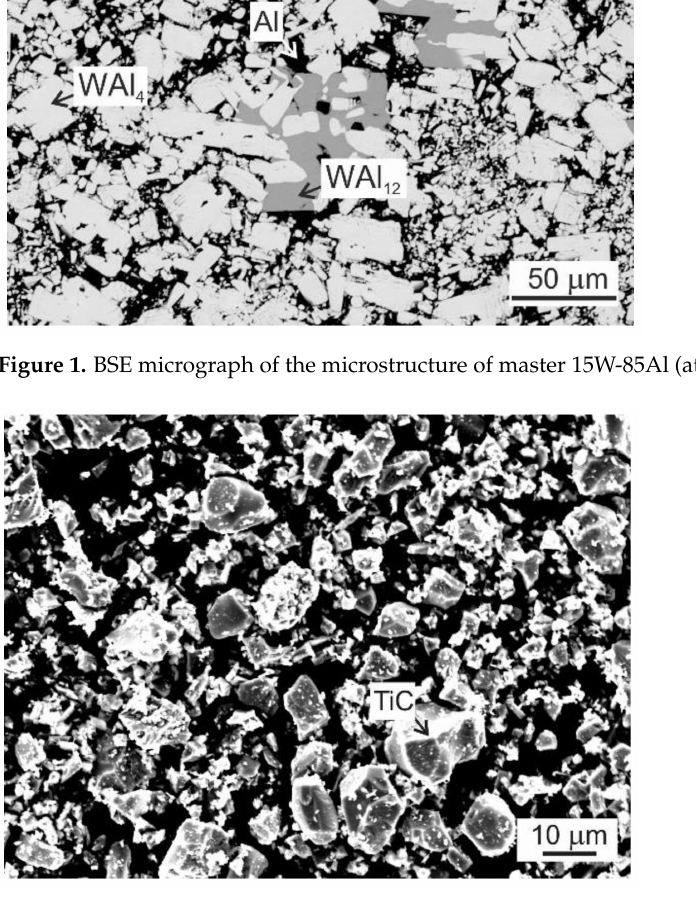
Figure 2. SEM micrograph of TiC